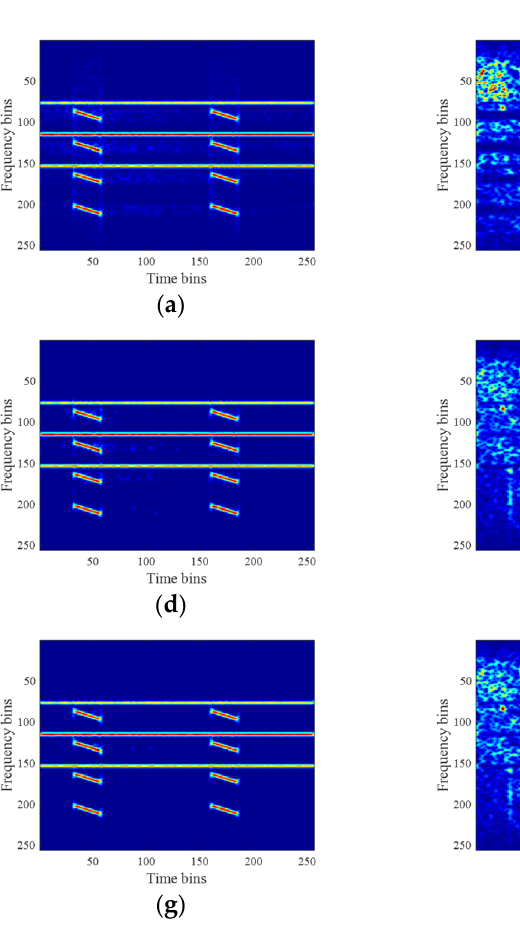
Figure 9. Analysis of the mitigation results. ( a , d , g ), the spectrograms of reconstructed RFI after applying GoDec, LRDS, and TFC-LRS, respectively. ( b , e , h ), the spectrograms of recovered TES after applying GoDec, LRDS, and TFC-LRS, respectively. ( c , f , i ) comparison of the spectrums of the original TES and the recovered TES after applying GoDec, LRDS, and TFC-LRS, respectively.